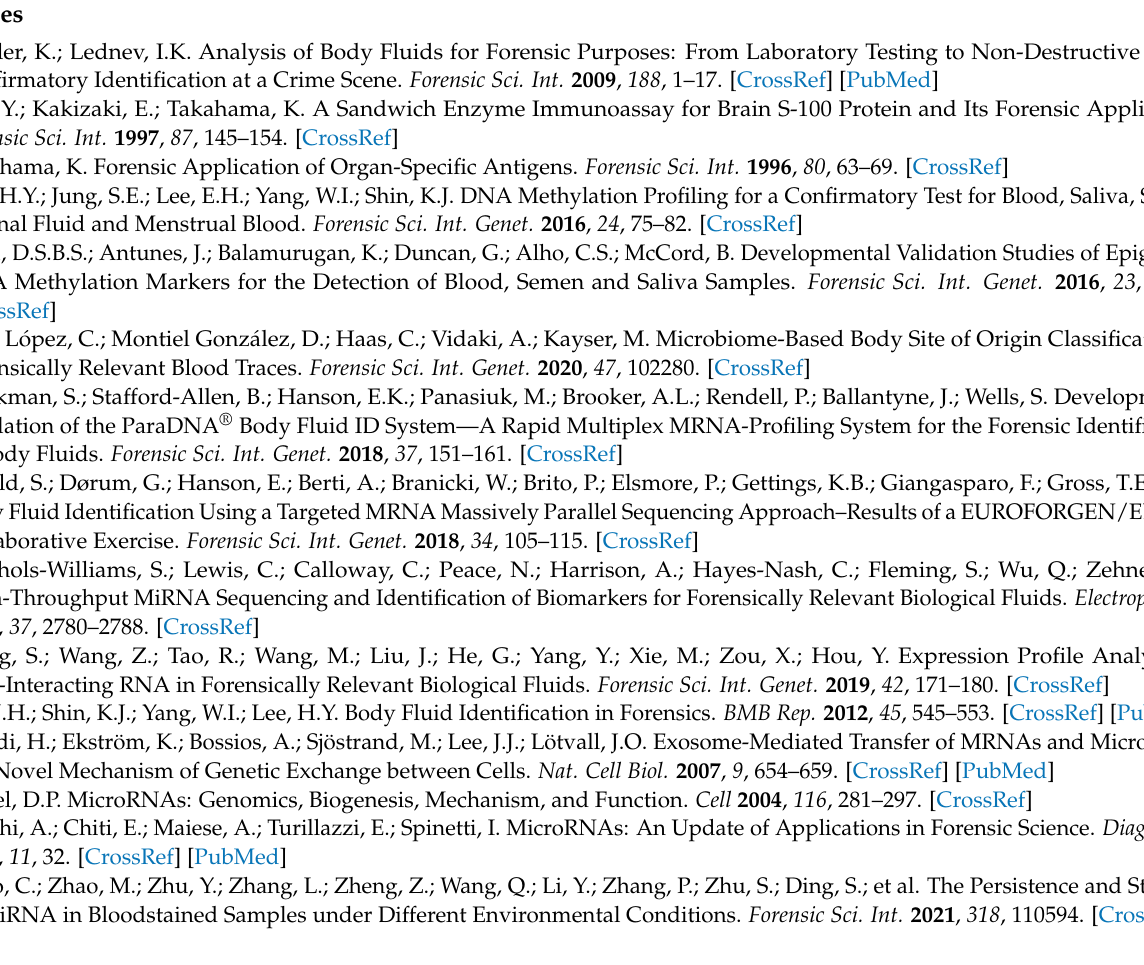
miRNAs reported, Figure S1: Expression profiles of the small RNA detected in all samples, Figure S2: The differential small RNAs of 15 pairwise groups. Red (up) and blue (down) spots represent significant differentially expressed small RNAs in corresponding pairwise groups ( q -value <